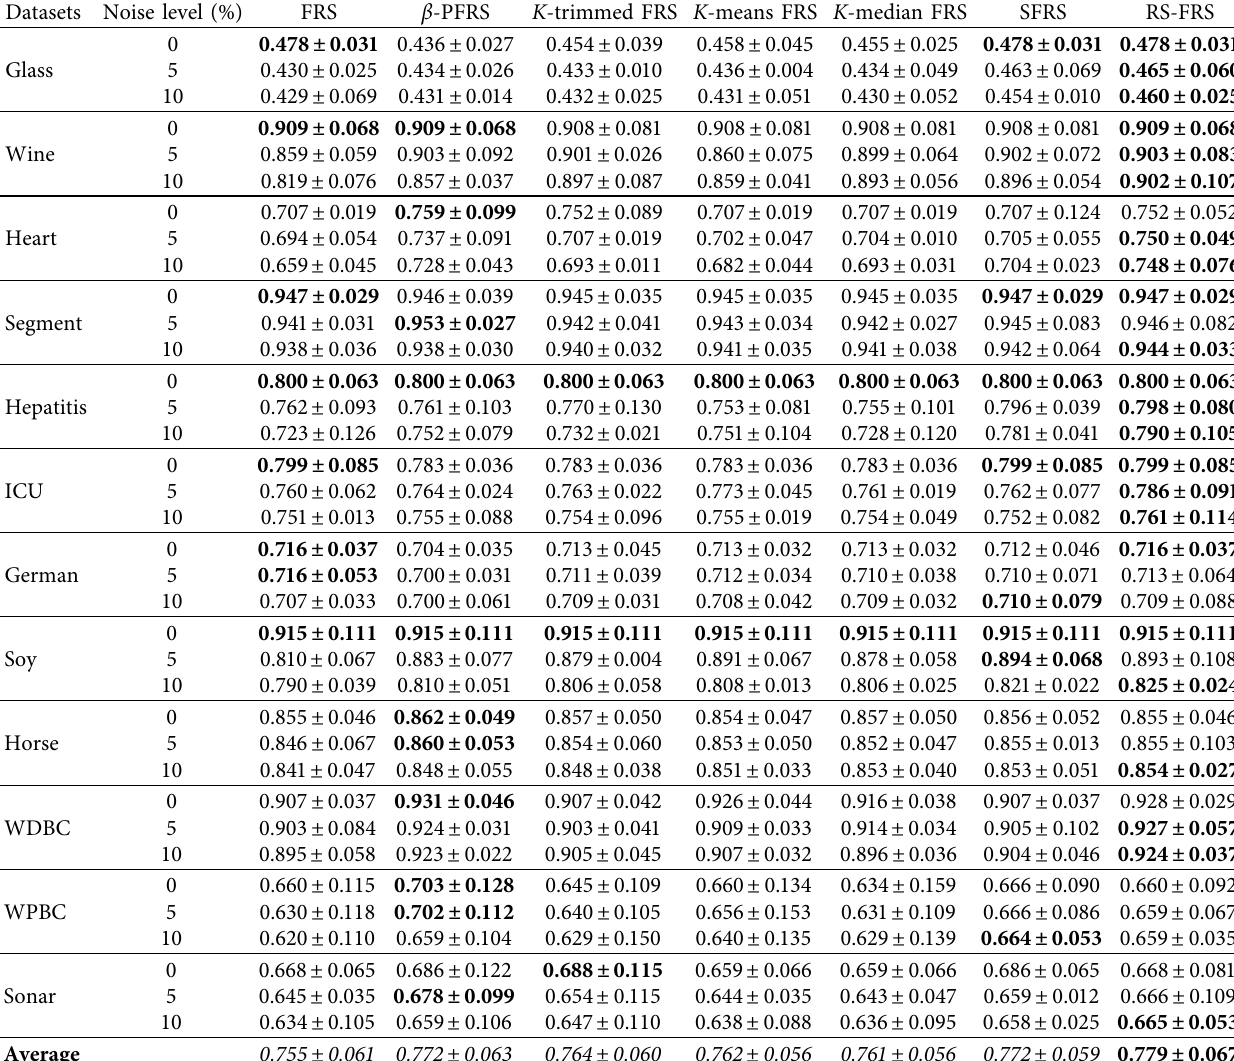
Table 3: Comparison of classification performance of different FRS models on CART in original and noisy data. Datasets Noise level (%)